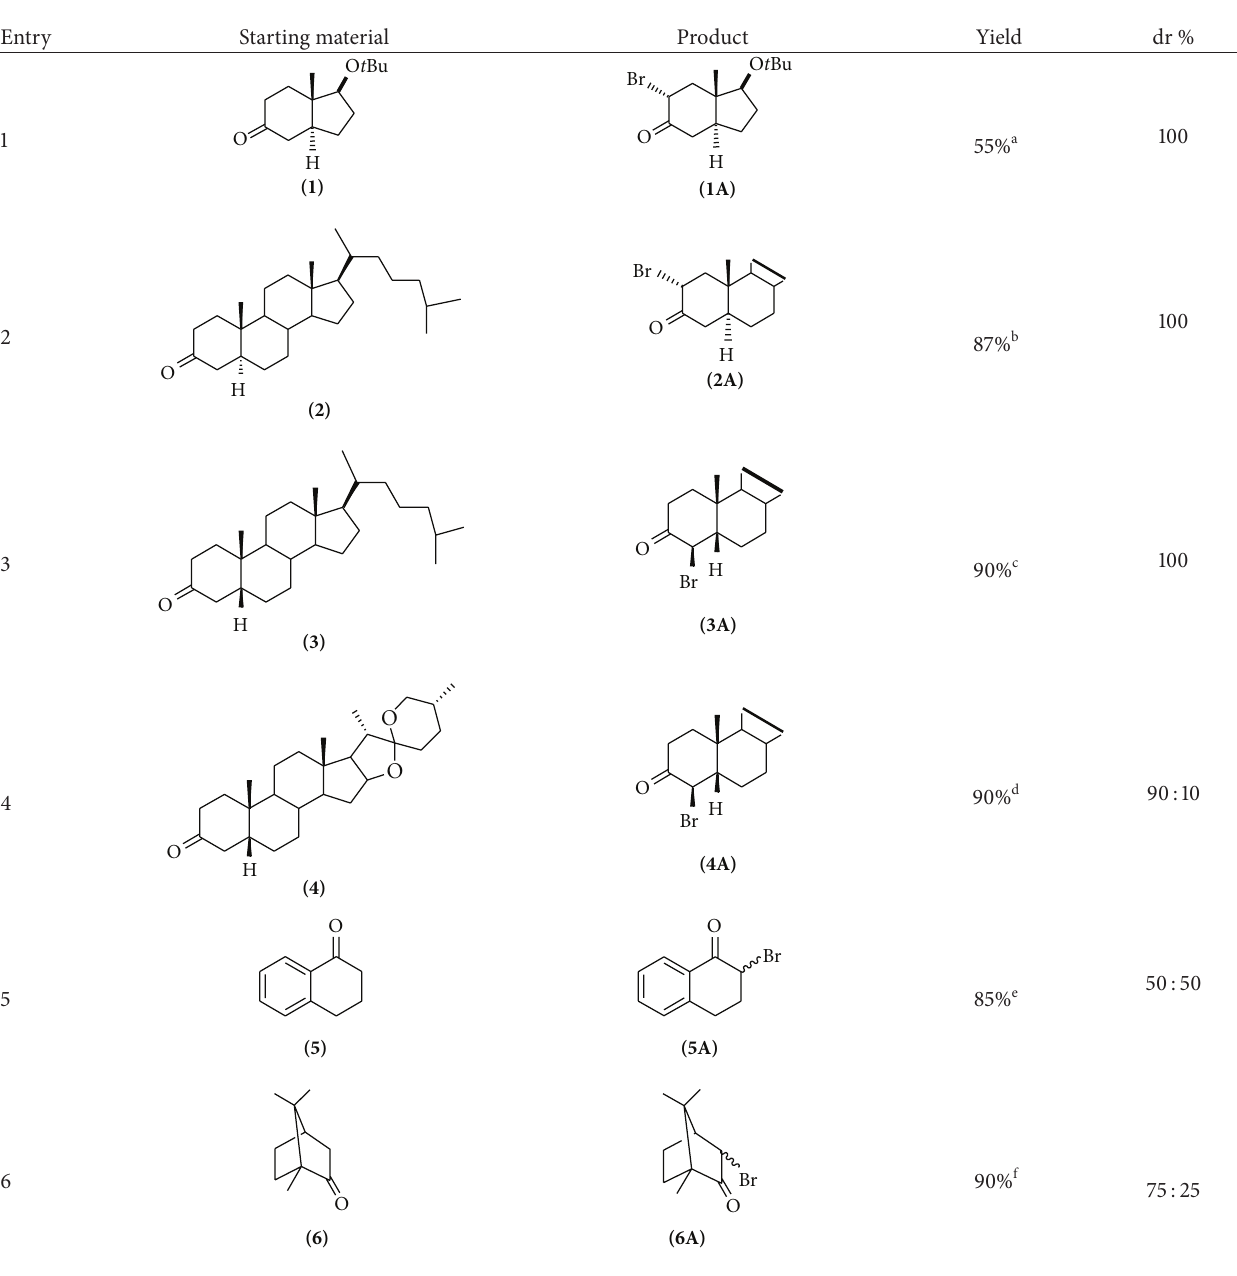
Table 1: Results of 𝛼 -bromination of